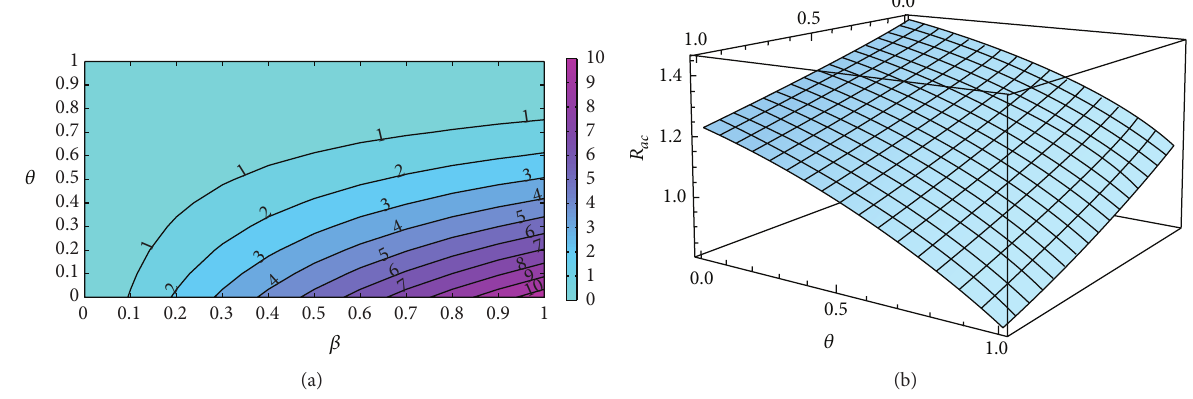
Figure 2: Simulations of model system (5) (a) showing the contour plots of 𝑅 𝑎𝑐 as a function of the effective contact rate for HSV-2 infection (𝛽) and the proportion of individuals who are adhering to the HSV-2 antiviral treatment (𝜃) ; (b) showing the effects of varying the treatment rate of acute HSV-2 and the proportion of individuals who are adhering to the HSV-2 antiviral treatment (𝜃) .